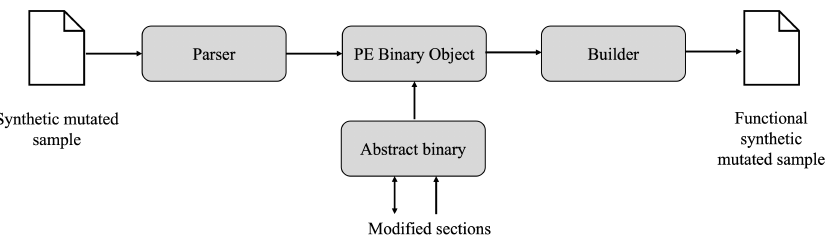
Figure 3. Instrumentation components of the synthetic sample in functional